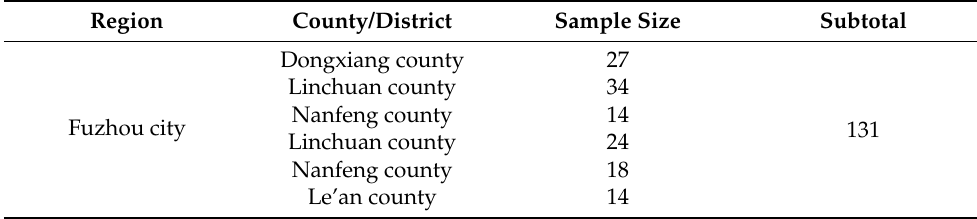
Table 1. Distribution of the